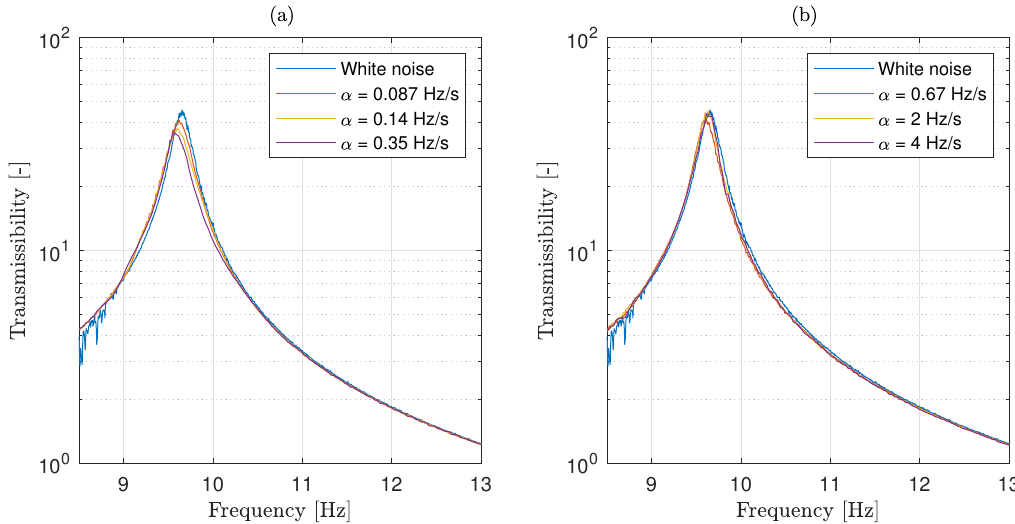
Figure 9. Comparison of the transmissibility obtained using a white noise excitation with those obtained using a sweep sine excitation for the spring coil case, for slower sweep rates ( a ) and faster sweep rates ( b